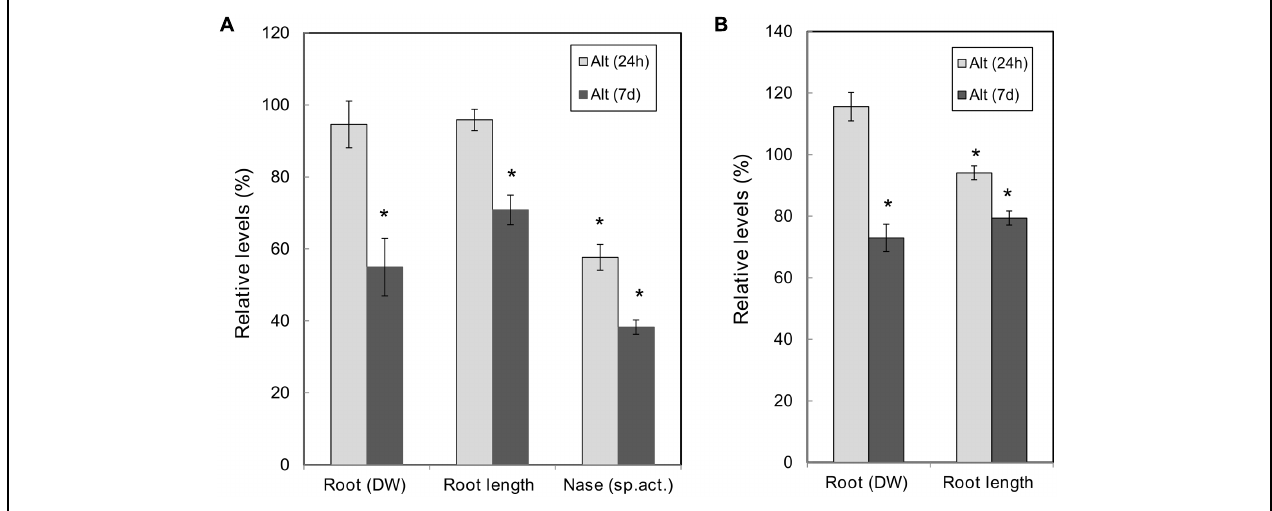
FIGURE 2 | Effect of Al toxicity on common bean plants. High Al (70 μ M AlCl 3 ) was added to (12 dpi) R. tropici -inoculated plants with active nodules (A) or to (12 days) fertilized plants (B) , for 24 h or 7 days as indicated. Values are expressed relative to those from nodulated (A) or fertilized (B) plants grown in control condition (100%). Nitrogenase specific activity, as determined by the